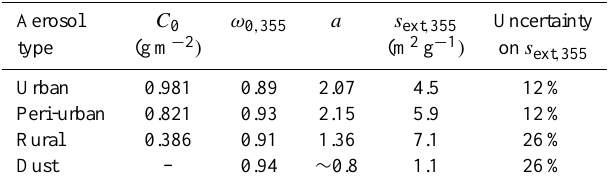
Table 5. Slope of the regression analysis ( C 0 ) , single scattering albedo ( ω 0 , 355 ) and Angstr¨om exponent ( a ) values used for the cal- culation of the specific extinction cross-section at 355nm ( s ext , 355 ) for urban, peri-urban and rural aerosol types. The uncertainties on the specific extinction cross-sections are also